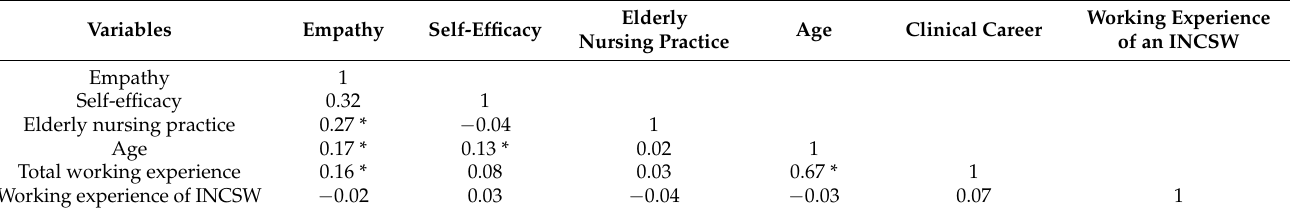
Table 3. Correlations among the study variables.